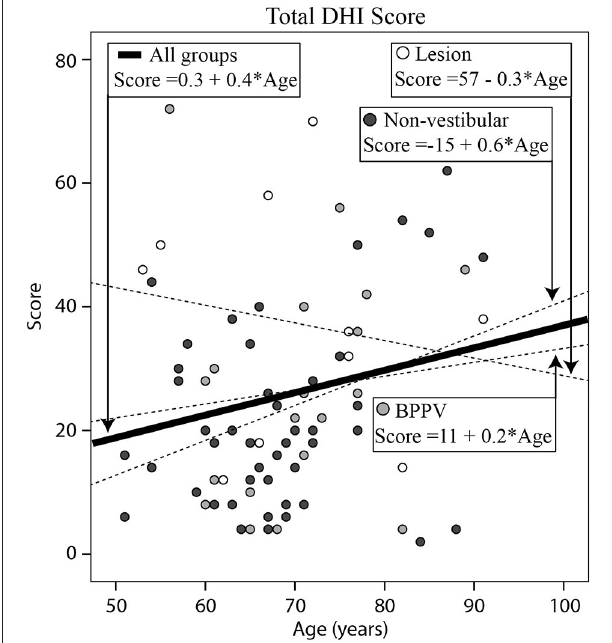
FIGURE 4 | Histogram of total (Emotional + Functional + Physical) Dizziness Handicap Inventory (DHI) score for each participant vs. their age, clustered by group with group and overall